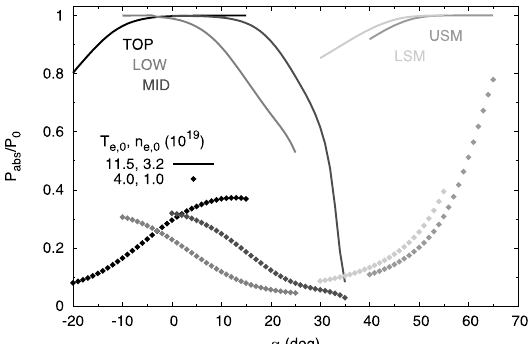
Fig. 3. Absorbed power fraction as a function of α for different T e , n e scaling.